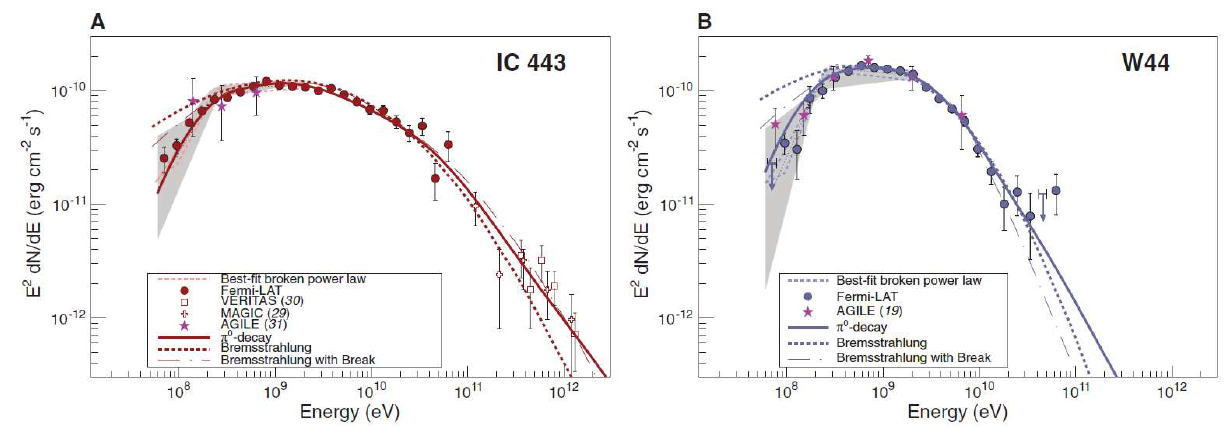
Figure 5: Gamma-ray spectra of the SNRs IC 443 and W44 and fitted models (Ackermann et al., 2013).